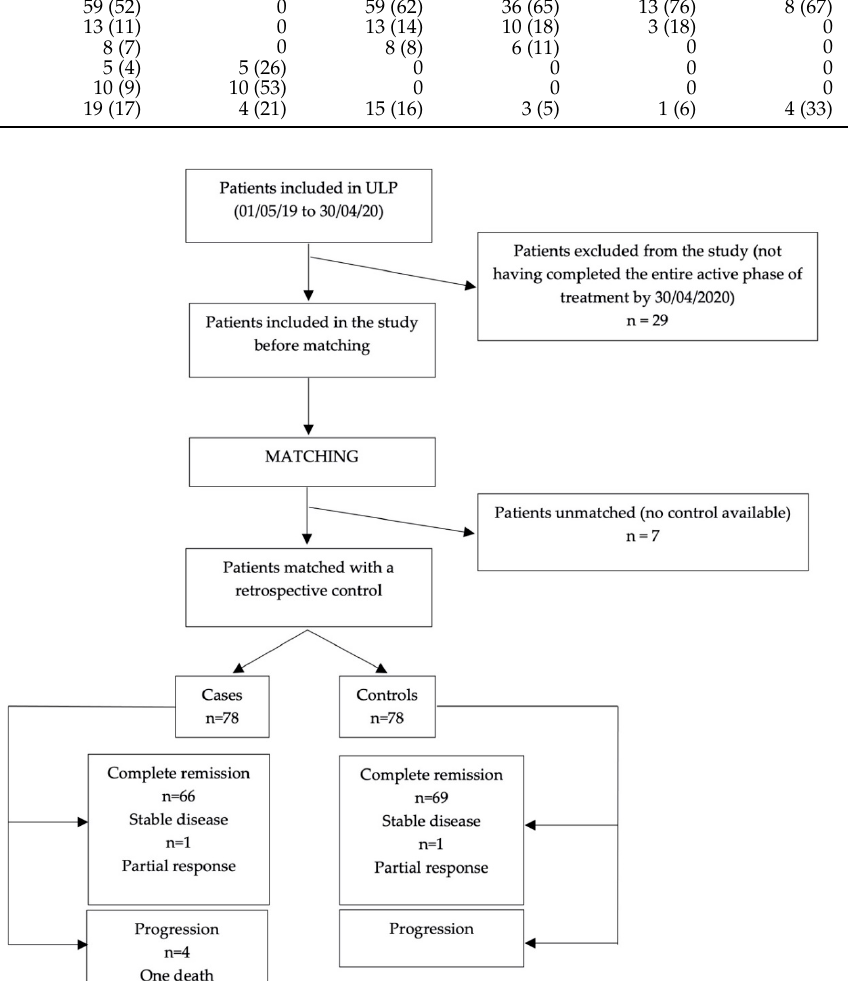
Figure 3. Flowchart. Figure 3. Table 2. Characteristics of cases and controls population.